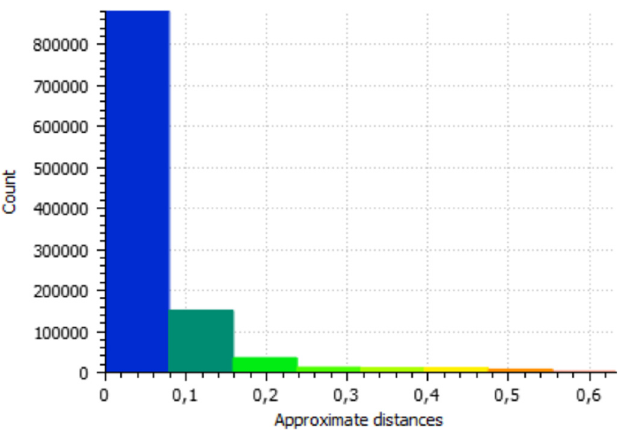
Fig. 18. Cloud distance diagram.